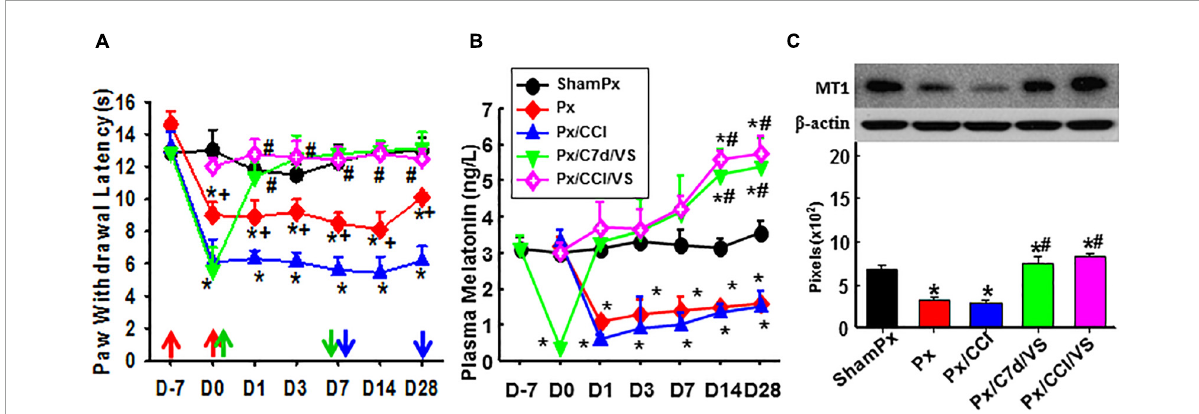
FIGURE5 Involvement of the pineal gland in the function of taVNS. Showing the effect of taVNS on nociceptive thresholds (A) , plasma melatonin concentration (B) , and the expression of MT1 in the amygdala (Day 7; C) in Px rats. D, day; the red arrow, CCI, Px, or sham operation; the green up arrow, treatments start; the green down arrow, treatments end; the blue arrow, sacrifice; ShamPx, sham Px operation; Px, pinealectomized; Px/CCI, Px, and CCI; Px/C7d/VS, Px, and CCI operation followed by taVNS treatments 7 days later; Px/CCI/VS, Px, and CCI operation followed by taVNS treatments immediately. * p < 0.05, as compared with the ShamPx group on the same day and the baseline of the same group; # p < 0.05, as compared with Px or Px/CCI groups; and + p < 0.05, as compared with the Px/CCI